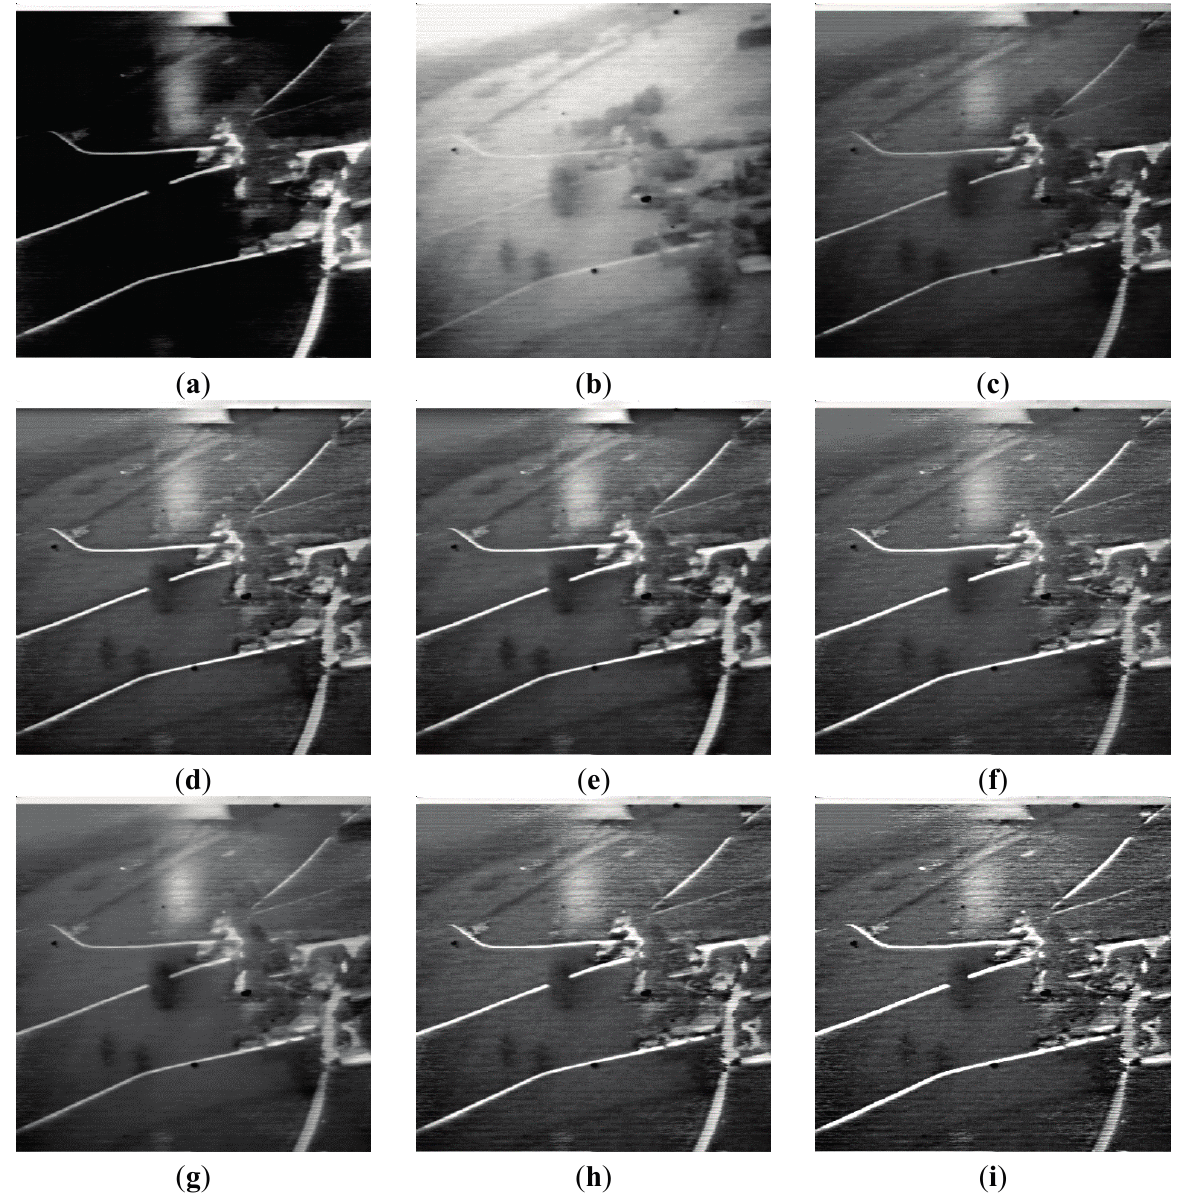
Figure 3. An example on Navi images. ( a ) Original infrared image ( b ) Original visual